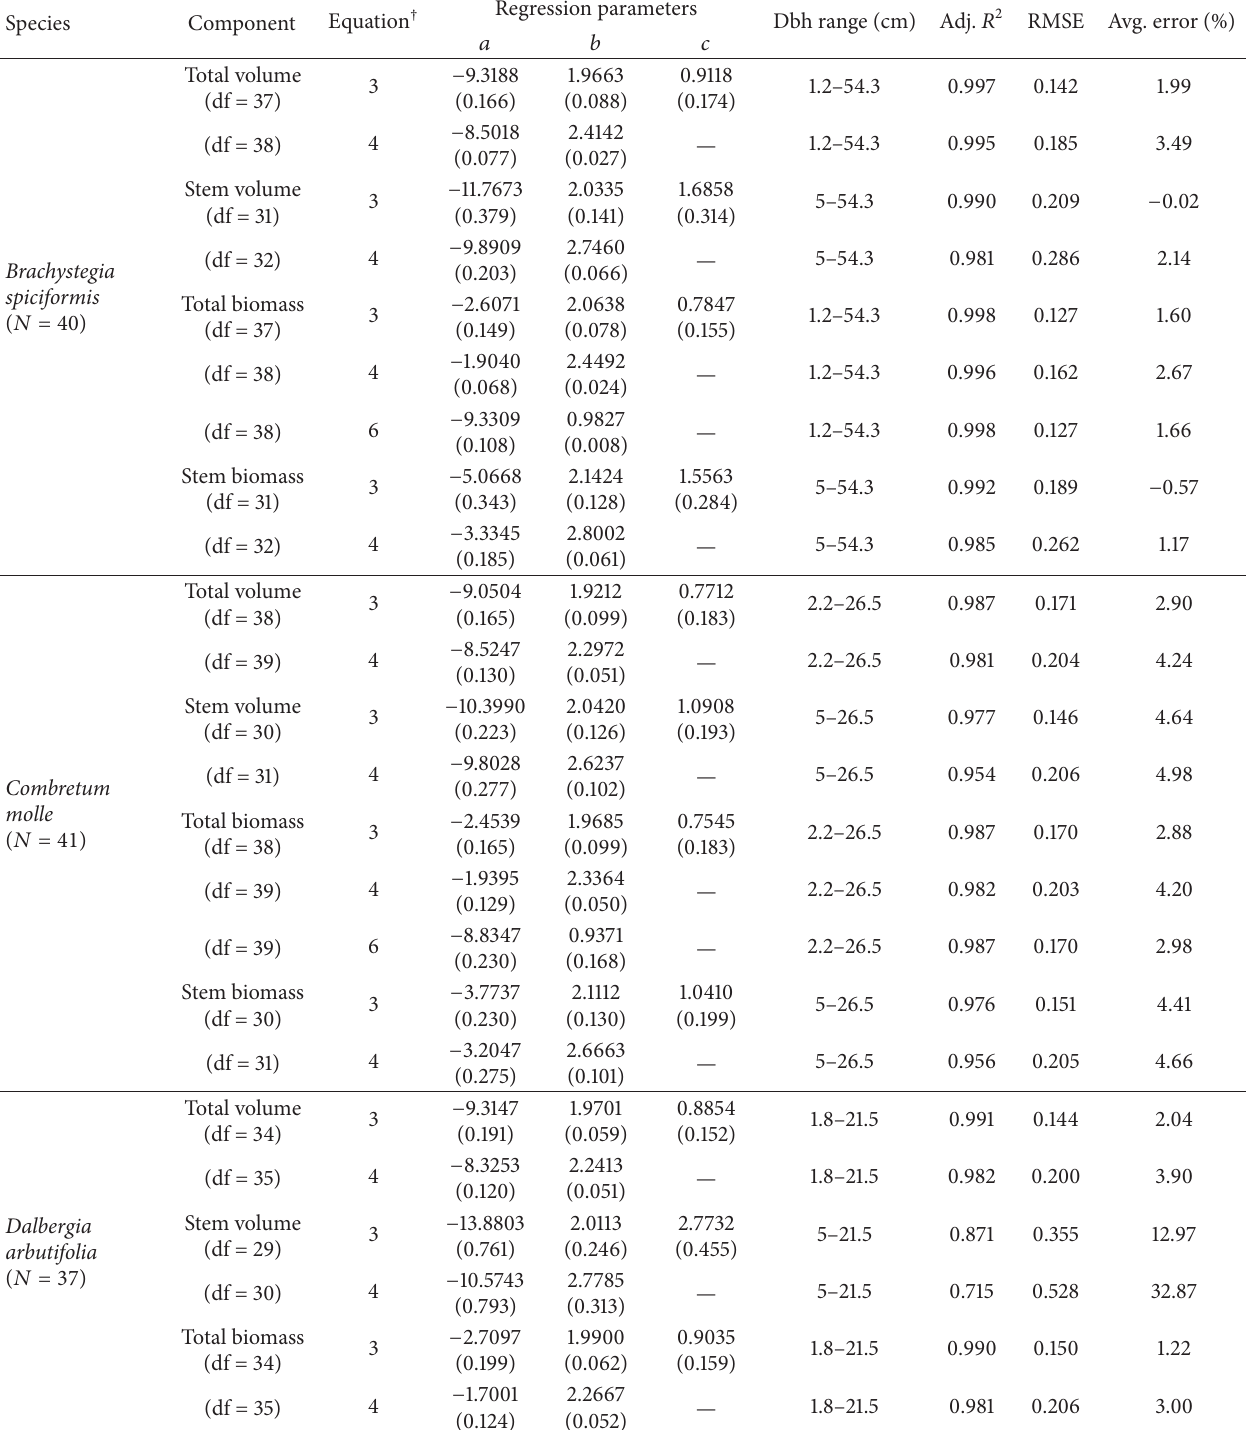
Table 1: Volume and biomass equations † for estimating total aboveground and stem ( ≥ 5cm) volume and biomass of three dominant